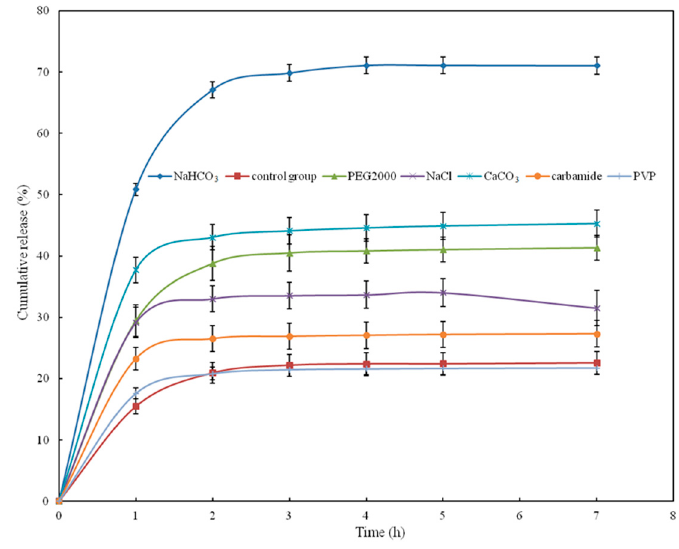
Figure 7. In vitro cumulative drug release from hydrogels in PBS solution (pH 7.4) at 37 °C.